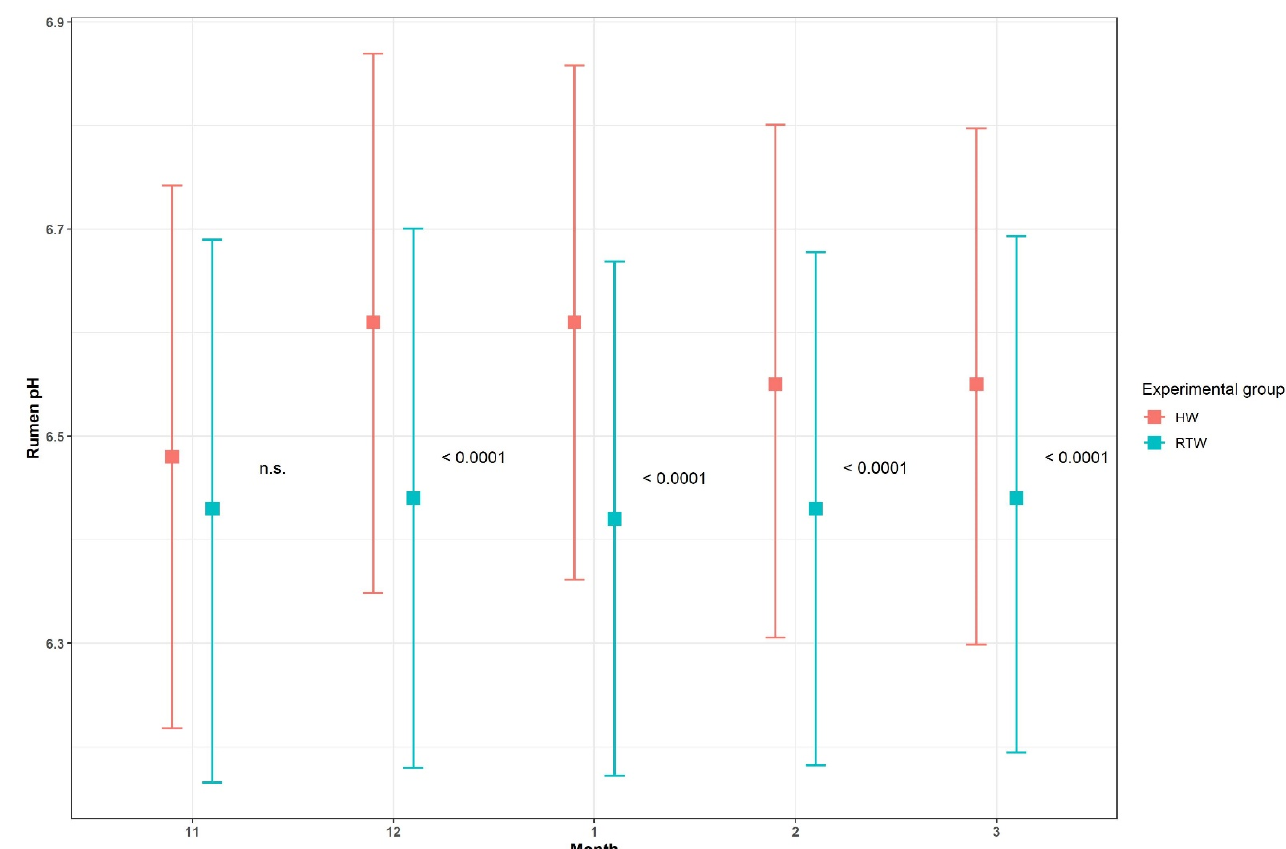
Figure 4. Rumen pH: the interaction between month and experimental group. Table 5. Ruminal parameters: ruminal temperature ( ◦ The experimental group had a significant effect on the amounts of time (min/day) that ruminal pH spent below 5.8 and 5.6 (Table 4). The ruminal pHs of the HW bulls lay under the thresholds of 5.8 and 5.5 for 34% (p < 0.001) and 29.9% (p < 0.001) less time